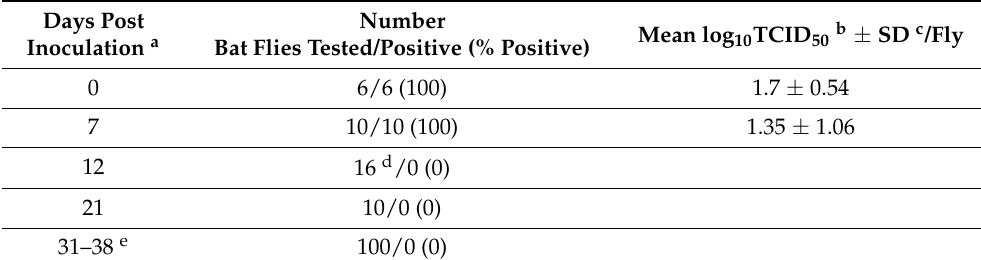
Table 5. Experiment 2. Quantitative reverse-transcription PCR (RT-PCR) results in bat flies (